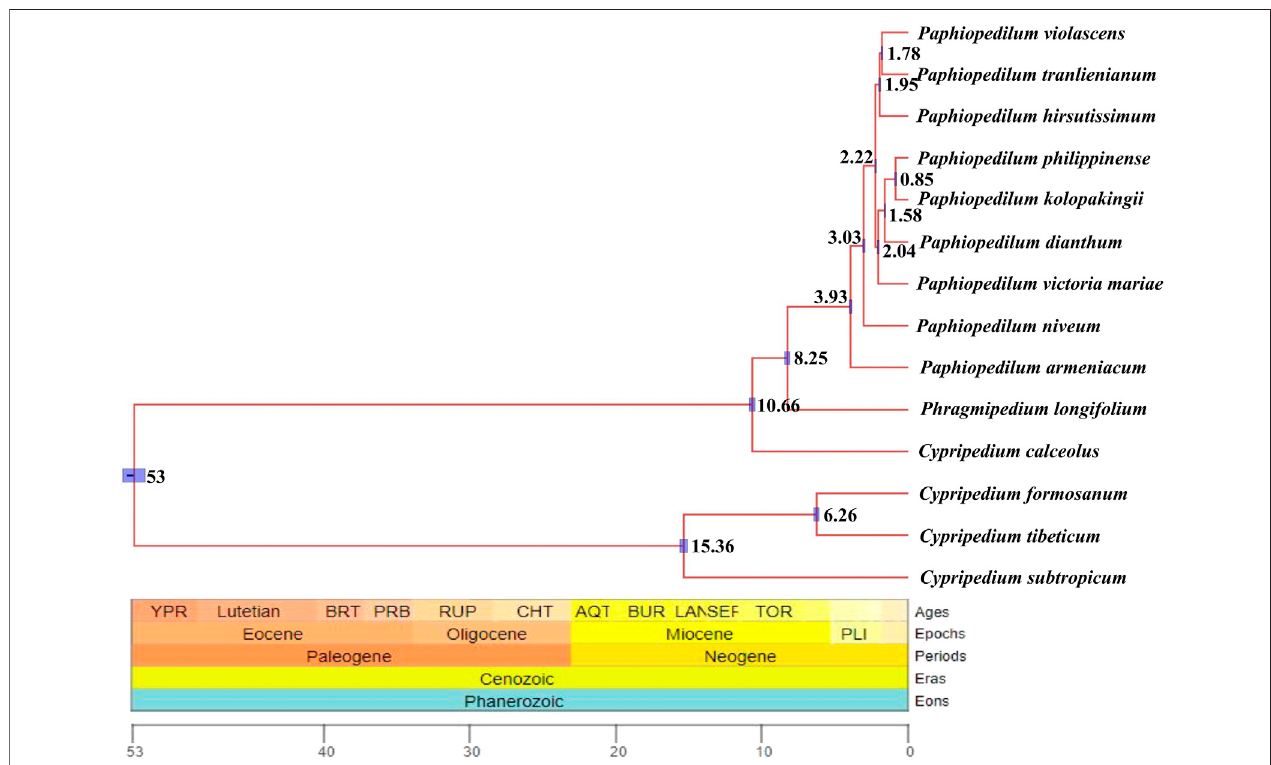
FIGURE 10 | Divergent time estimate of the nine Paphiopedilum taxa and Cypripedium taxa constructed by whole cp genomes. The branch length of cladogram re fl ected the divergent time, and the number beside the node denoted the node age, with the purple bar as 95% highest probability density (HPD). The posterior probabilities were 100% for all the